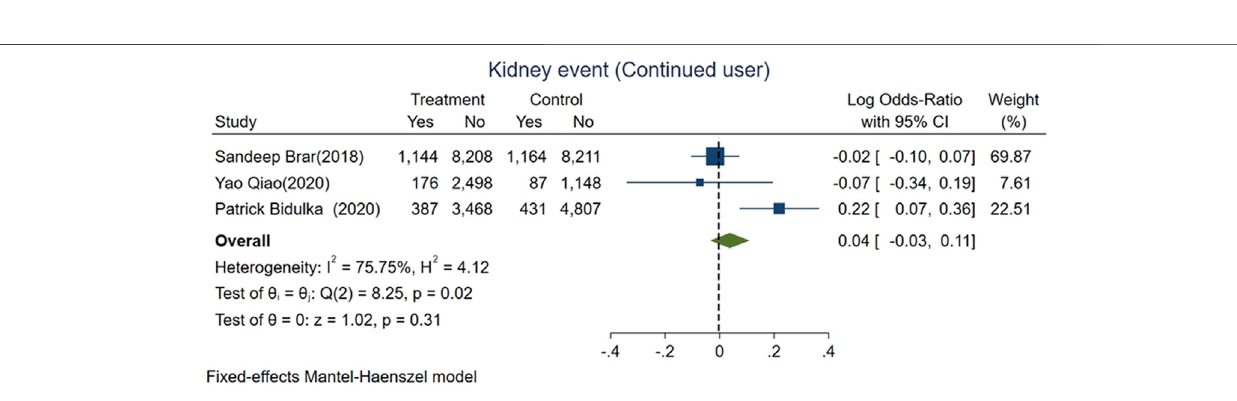
FIGURE 6 | Forest plot for adverse kidney events comparing continued ACEi/ARB use vs. de novo use in those exposed to ACEi/ARB after AKI.